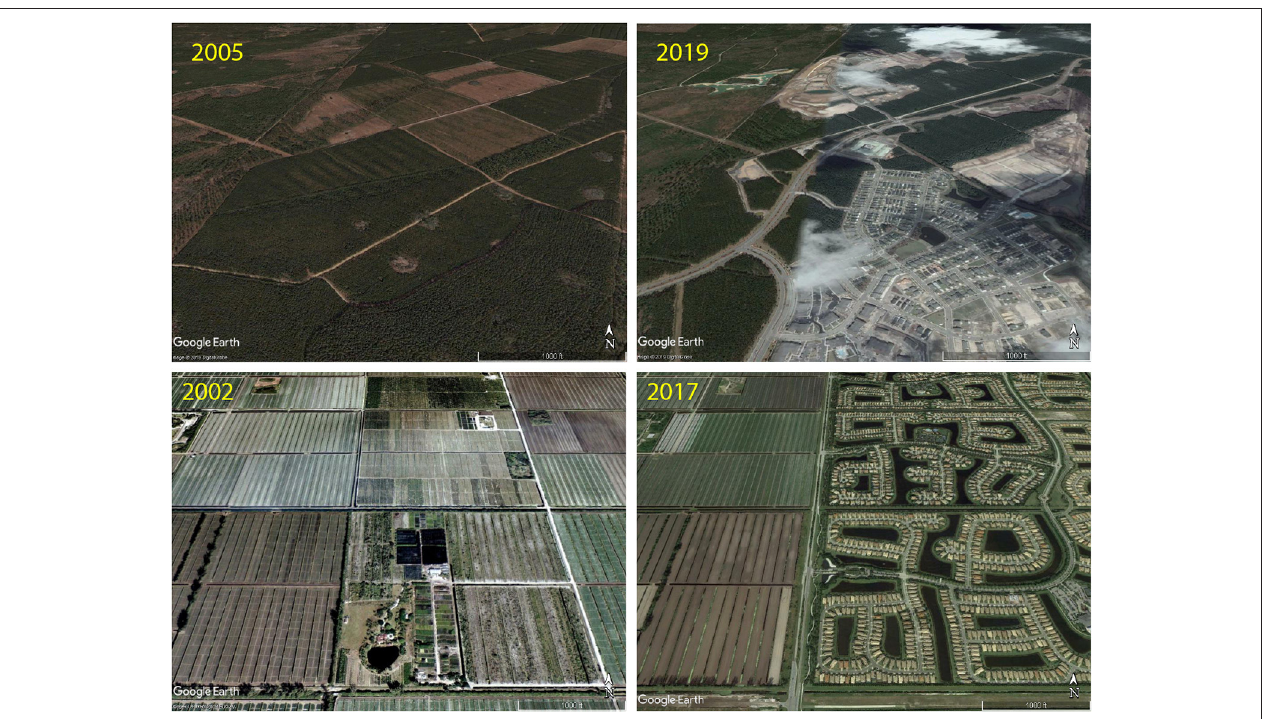
FIGURE 2 | Land use transitions to residential development highlight the use of wet detention ponds for stormwater management in the coastal zone. Upper panel: outside Charleston, South Carolina, 33 ◦ 3’33.01“N, 80 ◦ 8’48.85”W in the Sawmill Branch Creek watershed (HUC12: 030502010601); lower panel: outside Boca Raton, FL, 26 ◦ 30’35.22“N, 80 ◦ 11’29.72”W, in the Hillsborough Canal watershed (HUC12: 030902061101). Stormwater ponds in the two developed panels to the right side are visible in the form of dark areas surrounded by homes/buildings. In the upper-right panel, two large ponds are visible near the center, while many ponds (round or elongated) are visible in the lower-right panel. Upper-right panel, through partial cloud cover, also shows expansion of new developments with clear cutting and re-grading of the pre-existing managed-forested landscapes, and a borrow pit is found in the top-left corner. The lower-left panel also shows (at bottom-center) prior agricultural use of